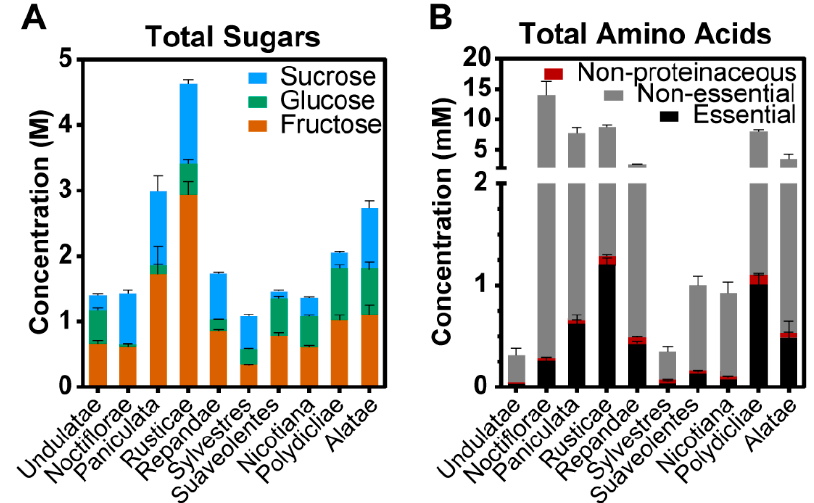
Figure 3. Sugar and amino acids profiles of ten Nicotiana Phylogenetic sections. ( A ) Sum of total sugar content highlighting the contributions of each of the three main sugars, sucrose, glucose and fructose. ( B ) Sum of total amino acid content categorized as nonproteinaceous, essential, and nonessential amino acids, Error bars represent the standard error, from 6 to 36 replicates depending on the section.